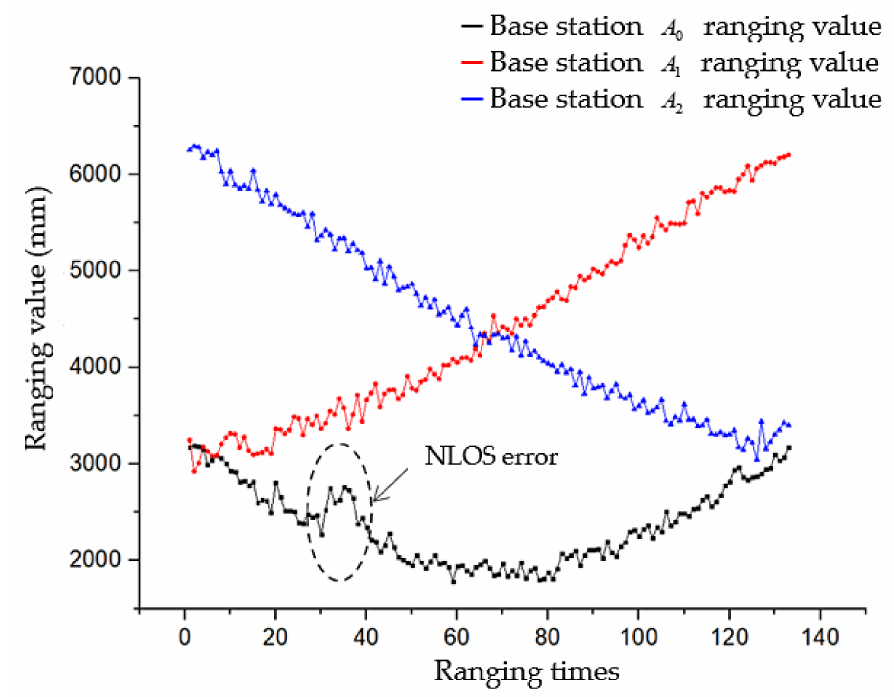
Figure 8. Base station ranging value.